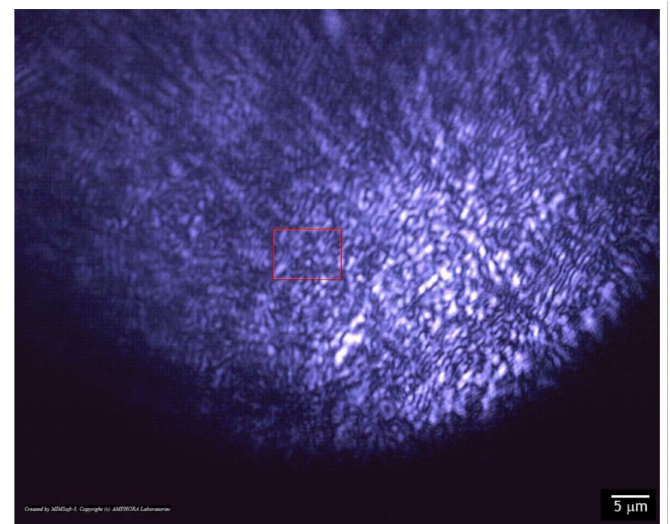
Figure 8. Photograph of AP-ZnO material obtained using a laser